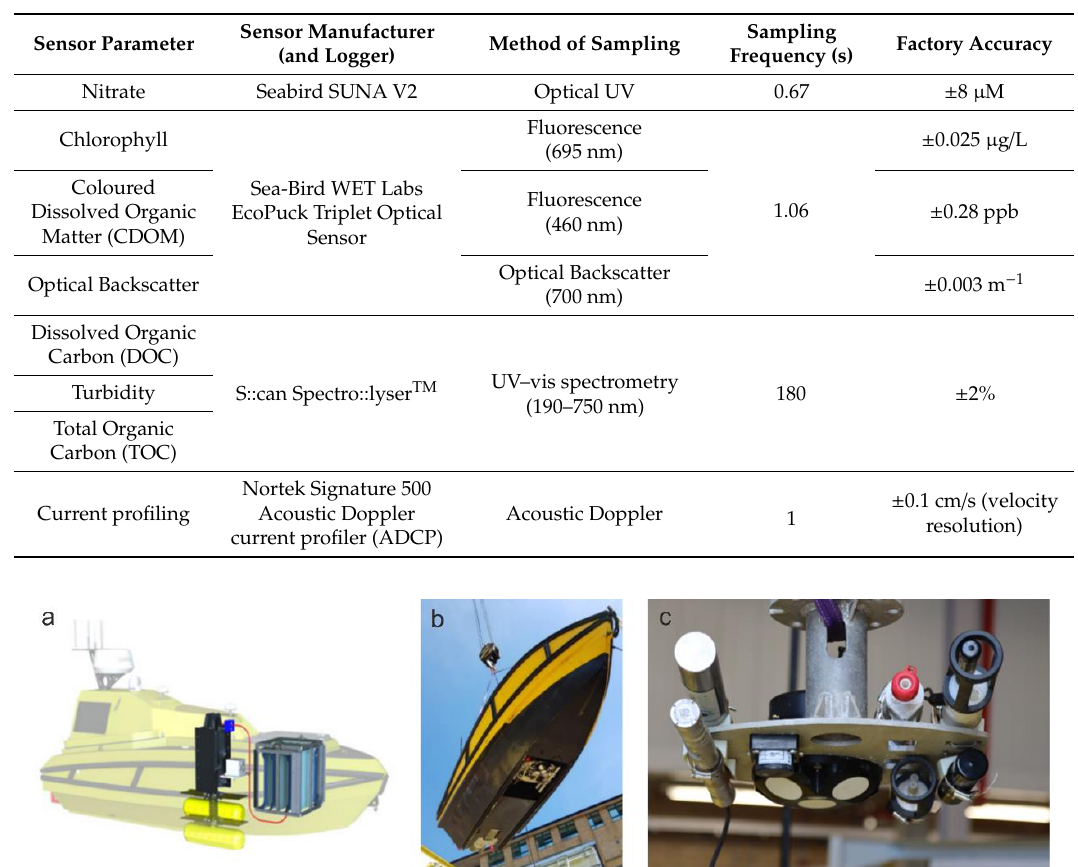
Figure 2. ( a ) Location of the sensor payload on CW4, which is lowered from the hull of the boat and connected to the on board computers (from [34]). Operation can be via remote desktop into these computers. ( b ) Bottom view of the CW4, highlighting the location of the payload. The payload is retracted into the hull during transportation and for protection when not in use, as pictured. ( c ) Detailed view of the scientific sensors mounted on a metal plate. Pictured sensors are listed in Table 1.